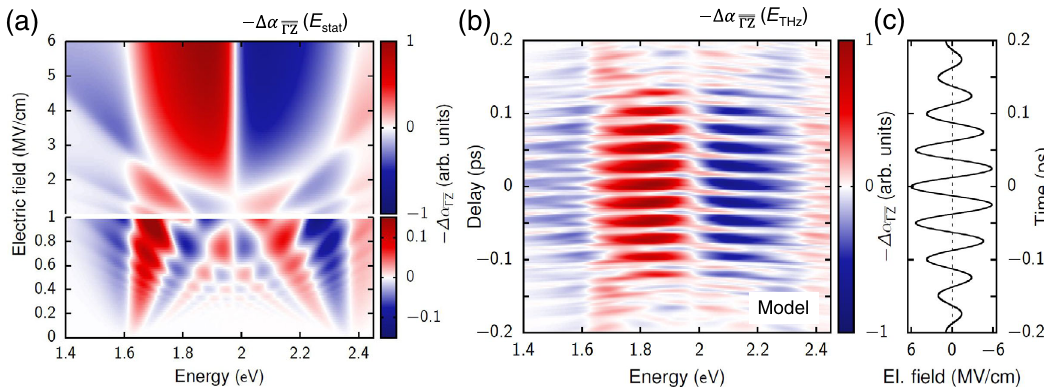
for static fi elds from a cosine Z